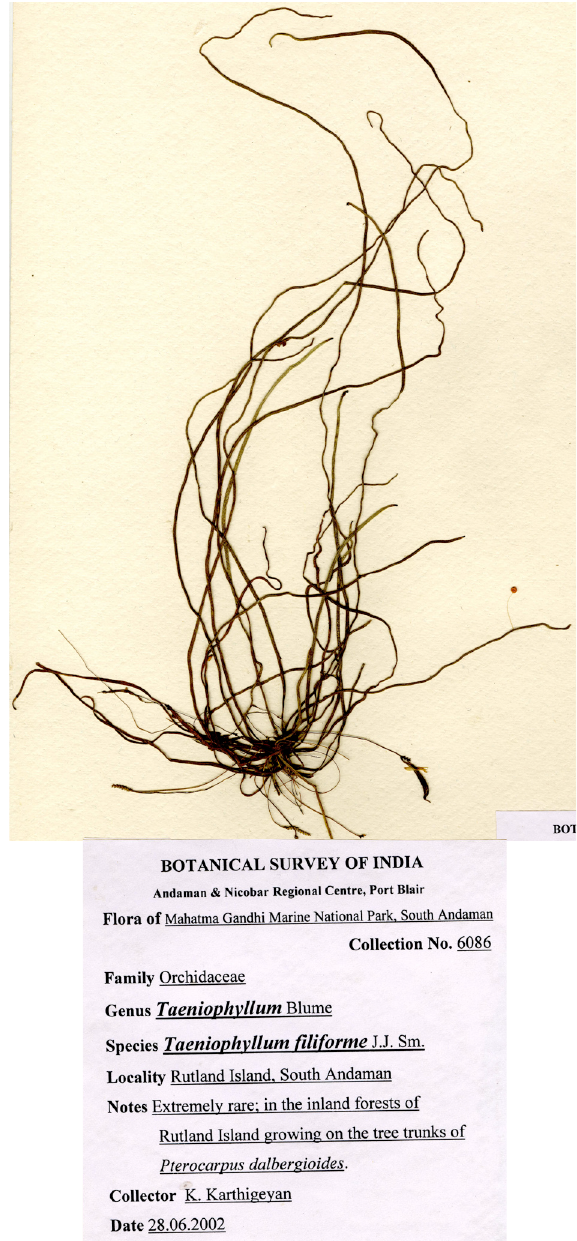
Image 3 . Herbarium of Taeniophyllum